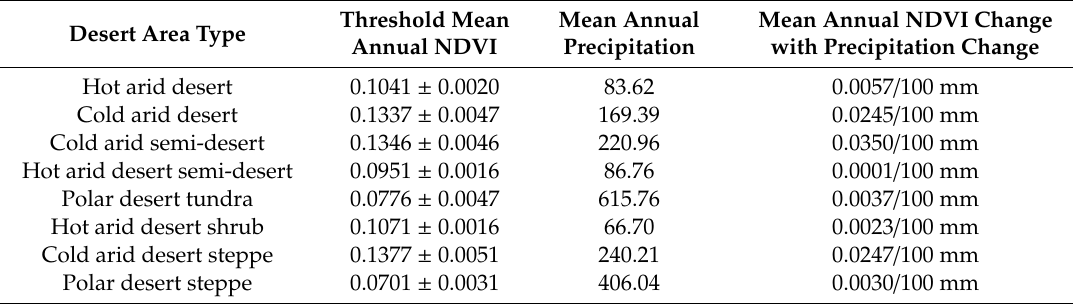
Table 1. Threshold value of mean annual NDVI and its response to precipitation change under water balance between 1982 and 2015 in di ff erent desert areas over the Silk Road Economic